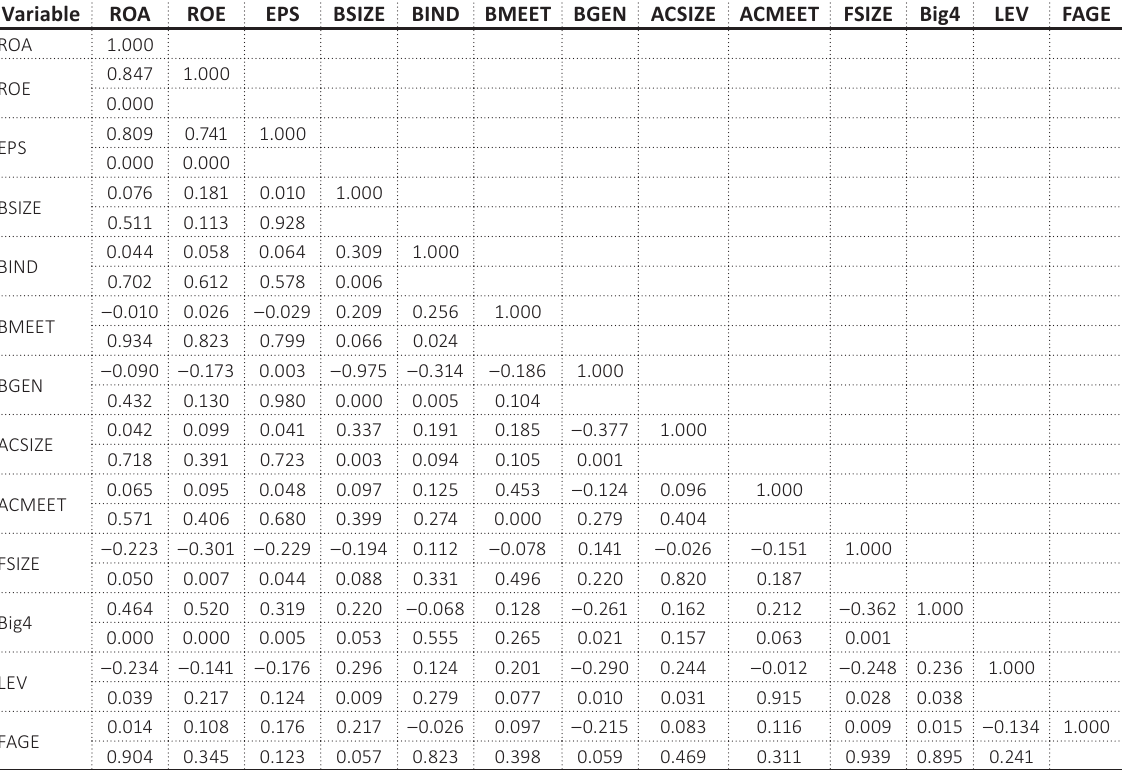
Table 6. Correlations matrix of study